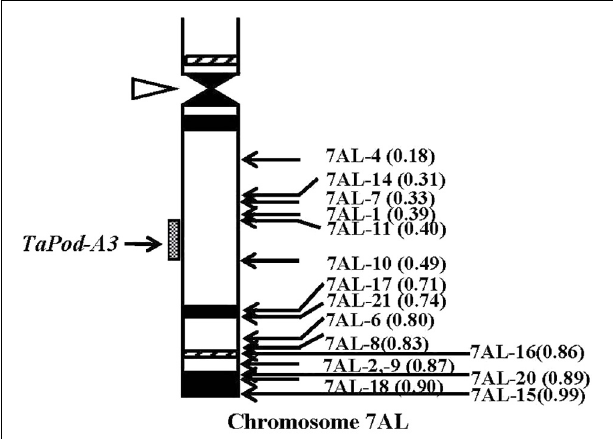
FIGURE 6 | Physical map of Chinese Spring (CS) chromosome 7AL. The identification of deletion lines and fraction arm length (FL) values of breakpoints ( parentheses ) is shown on the right . C-banding patterns of chromosomes are taken from Gill et al. (1991). The chromosomal region ( gray hatched bar ) from FL = 0.40 to FL = 0.49 indicates the putative location of the TaPod-A3 gene. Chromosome long arms point toward the bottom and the open arrow ( left ) shows the position of the centromere.